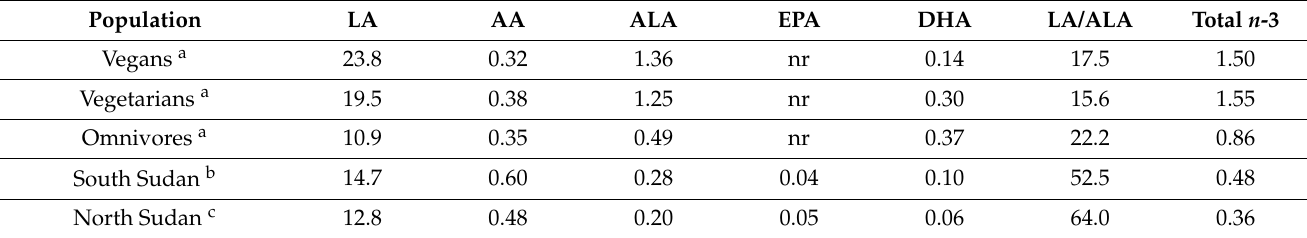
Table 6. Human milk fatty acids (% total fatty